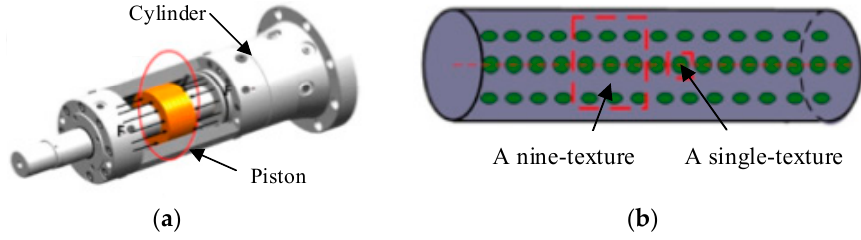
Figure 11. The hydraulic cylinder with micro textures [32]: ( a ) structure of hydraulic cylinder; ( b ) schematic diagram of single-textured and nine-textured piston.